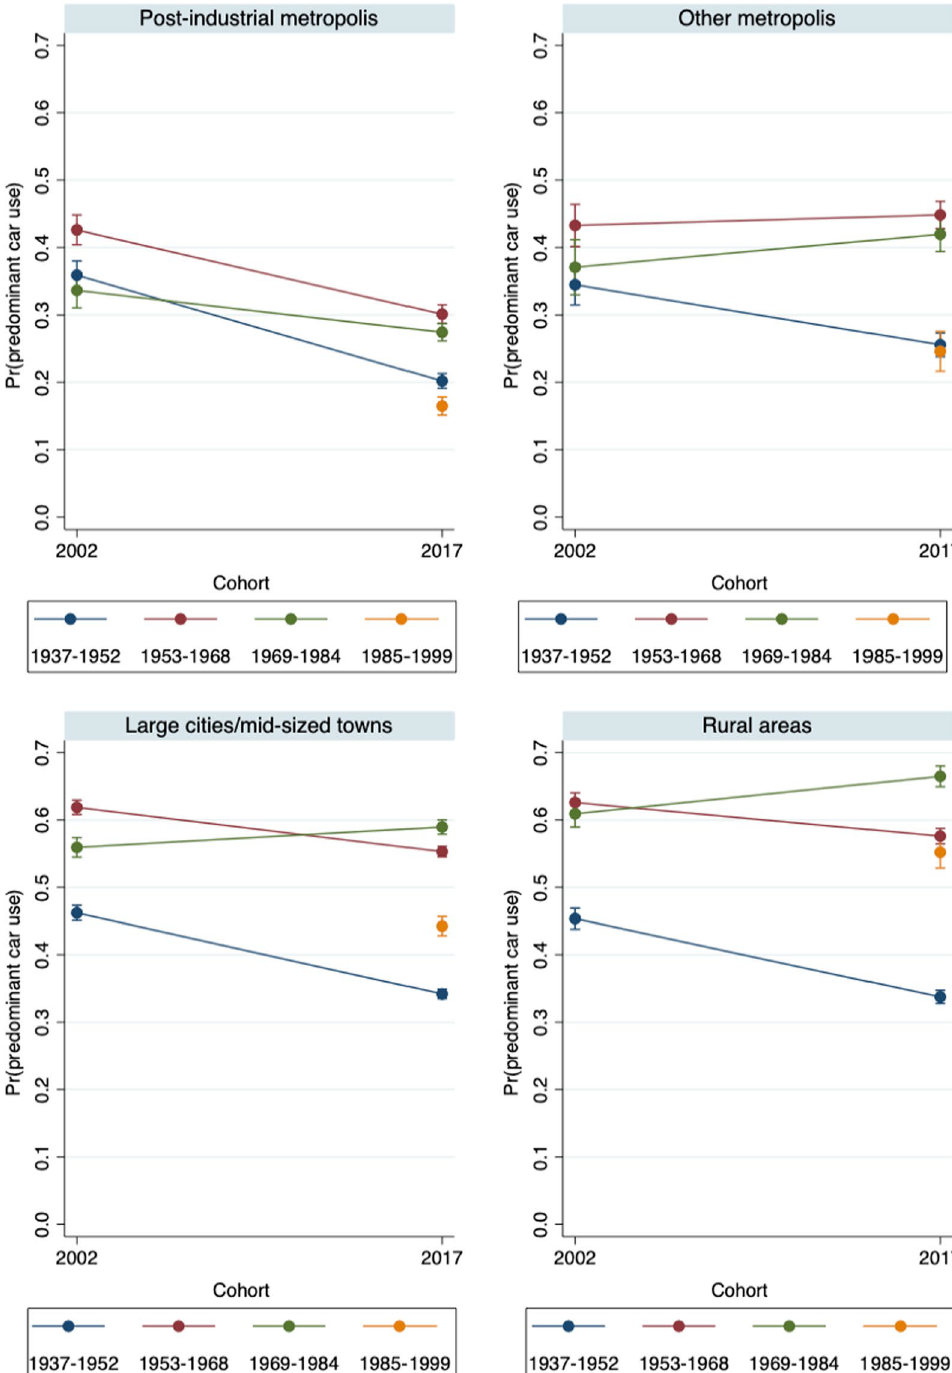
Fig. 2 Predicted probabilities of predominant regular car use in 2002 and 2017 – by settlement type (Model 1). Source: Mobility in Germany: MiD person-time-series dataset (own calculations). Note : Predominant car use is defined as (almost) daily car use and bicycle use of at most 1 to 3 times per week. Survey weights are applied. See also Table 4 for main effects and standard